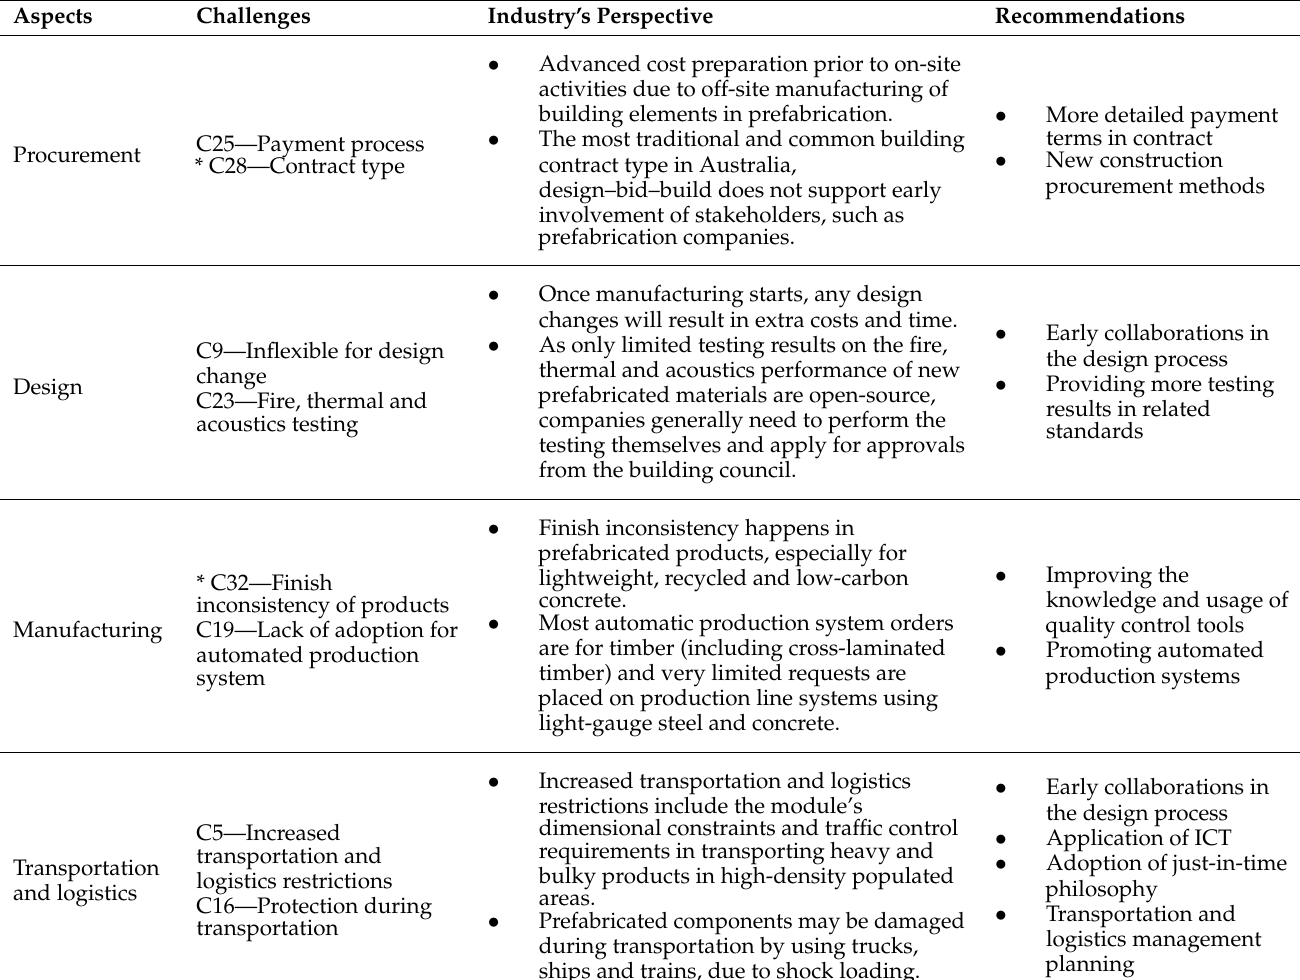
Table 6. Eight aspects of Australian prefabrication challenges and